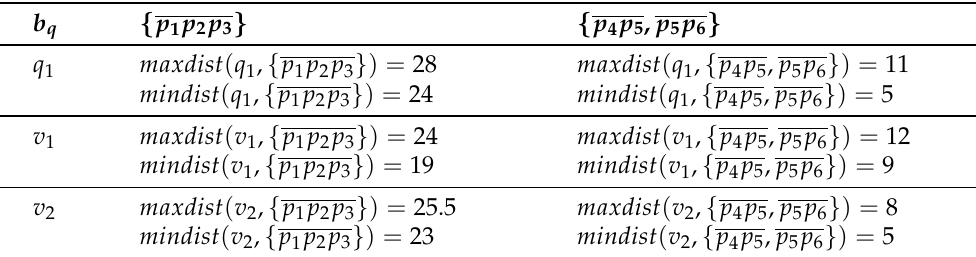
Figure 10. maxdist ( v 2 , { p 4 p 5 , p 5 p 6 } ) = 8 and mindist ( v 2 , { p 4 p 5 , p 5 p 6 } ) = 5: ( a ) maxdist ( v 2 , p 4 p 5 ) = 8 and mindist ( v 2 , p 4 p 5 ) = 5; ( b ) maxdist ( v 2 , p 5 p 6 ) = 8 and mindist ( v 2 , p 5 p 6 ) = 5. Table 3. Maximum and minimum distances between border points and data